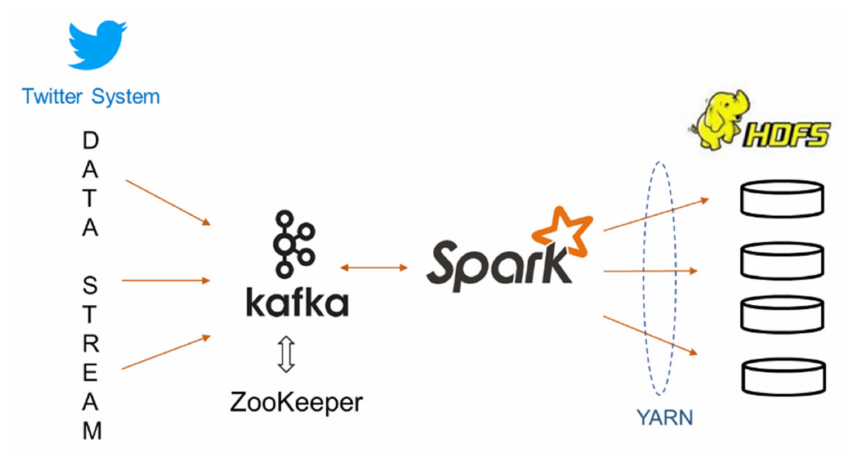
Figure 7. The architecture of data collection